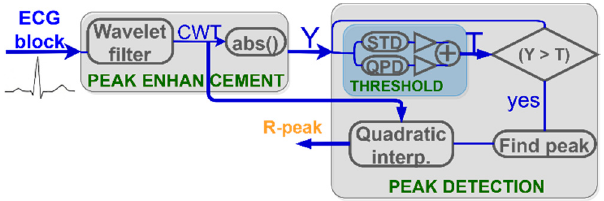
Figure 6. PALMS ECG algorithm block diagram: CWT (continuous wavelet transformation), Y (absolute value of CWT), STD (standard deviation), QPD (quasi-peak detector), and T (threshold).